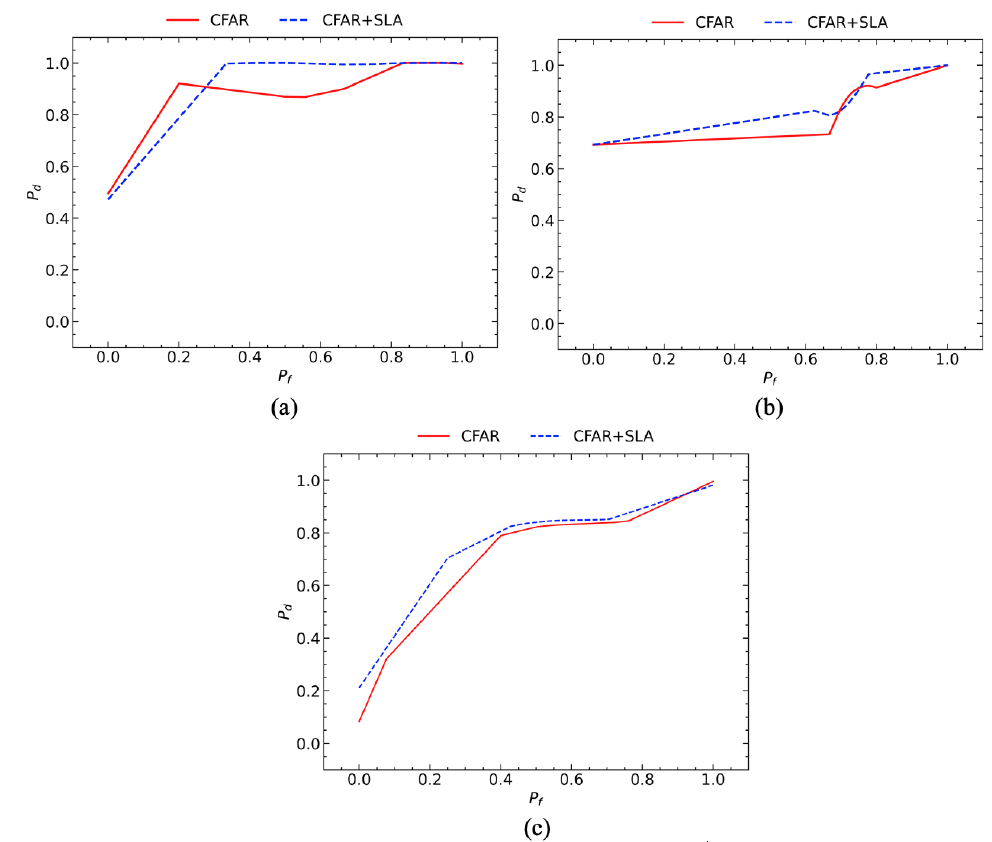
Figure 11. ROC evaluation of COSMO-SkyMed (121 targets labeled) ( a ), SAOCOM (36 targets labeled) ( b ), and Sentinel-1 (333 targets labeled) ( c ) products in the Sardinia